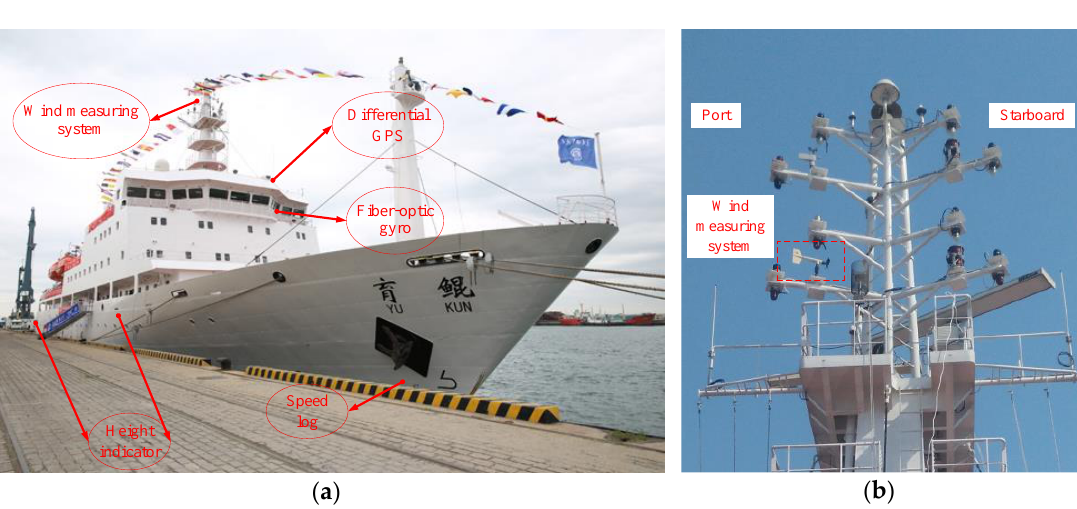
Figure 5. Instrument installation on board of Yukun. ( a ) The position, velocity and heading angle measuring instrument; ( b ) the wind measuring system installation on the mast.